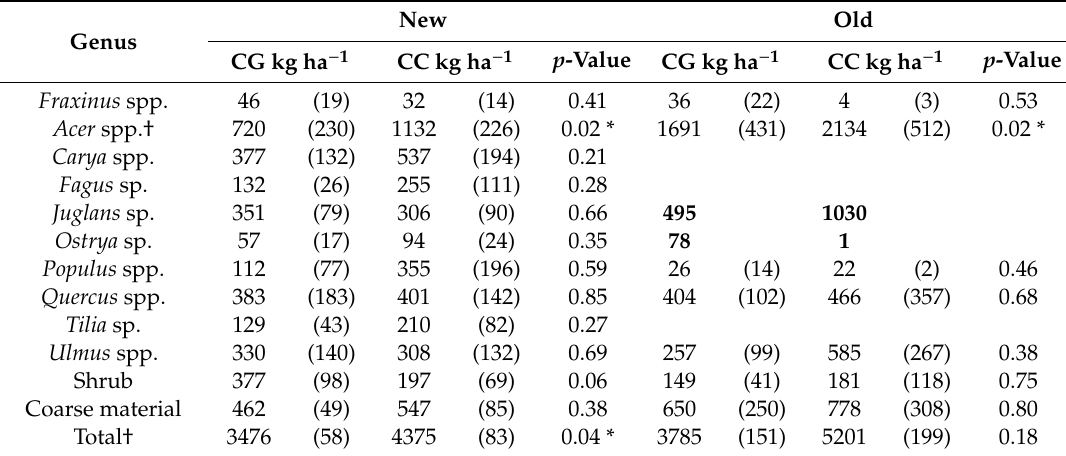
Table 1. Mean ( ± SEM) litter deposition (kg ha − 1 ) for Canopy Gap (CG) plots and Canopy Closed (CC) plots in new and old infestation sites.